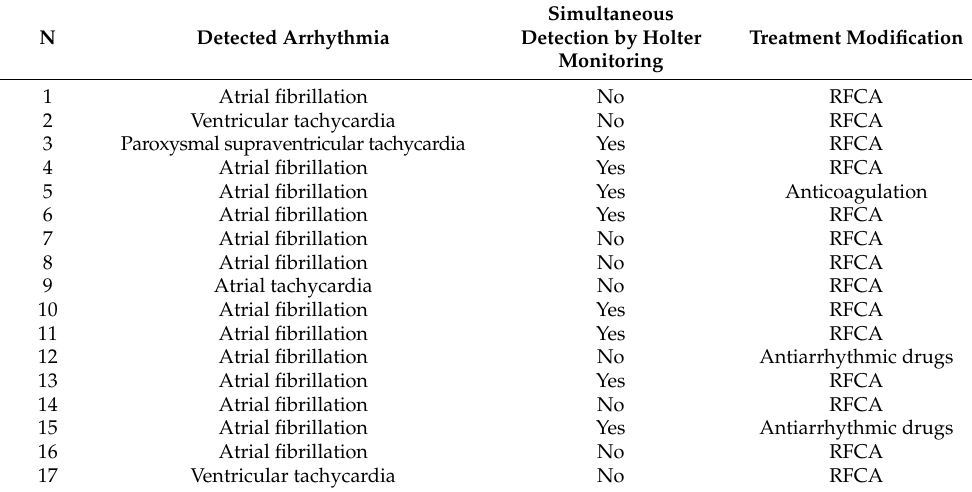
Simultaneous Detection by Holter Treatment Monitoring